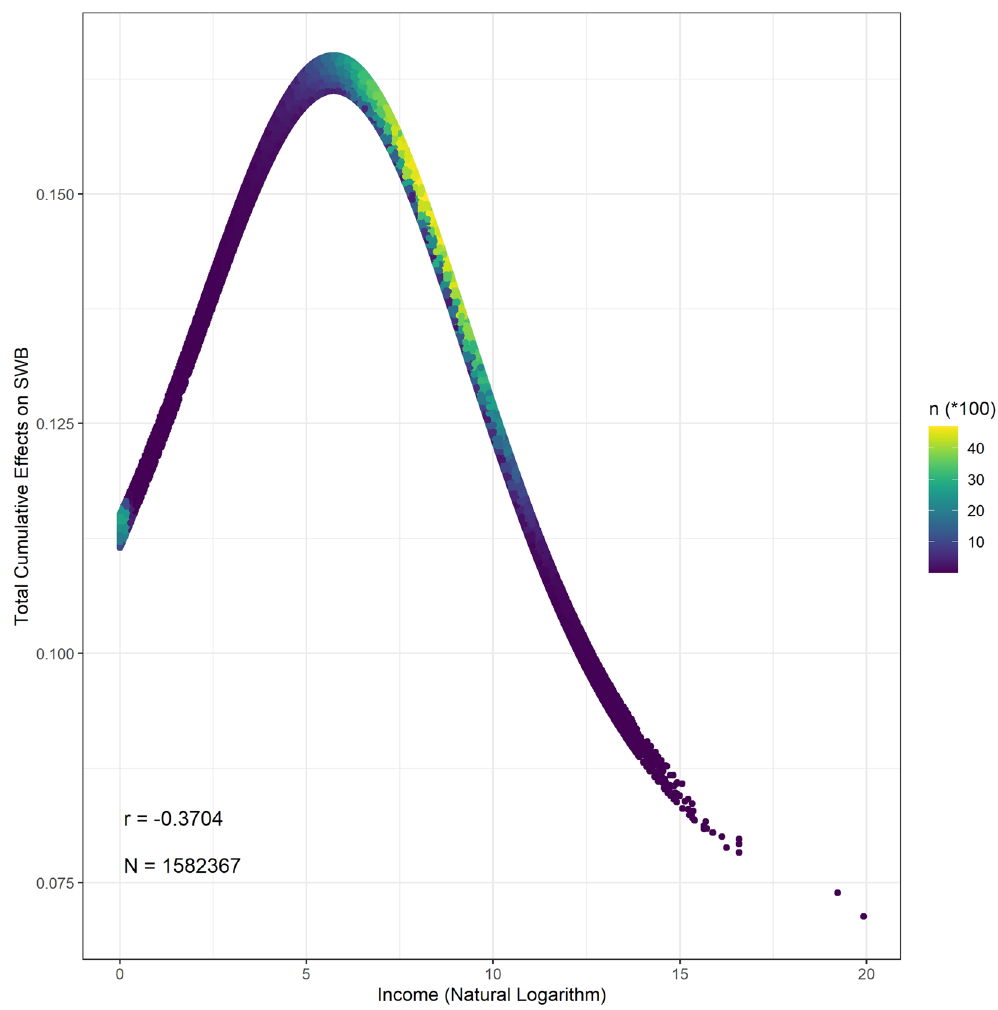
Figure 3. The distribution between the total cumulative effects of income on